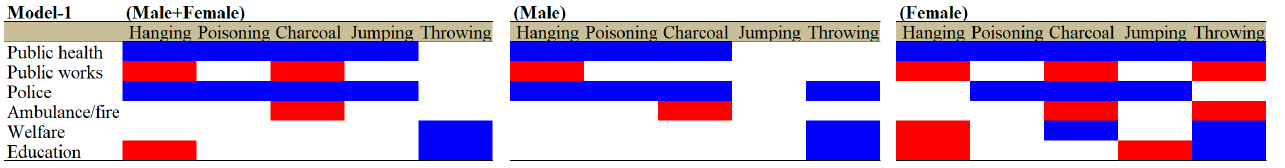
Figure 1. Impacts of total amount of the financial expenditure of six divisions (public health, public works, police, ambulance/fire, welfare and education) prefectures/municipalities on suicide mortalities by five major suicide means (hanging, poisoning, charcoal burning, jumping and throwing suicide) of both gender (males plus females), males and females between 2009 and 2018 using fixed-effect model analyses of hierarchal linear regression with robust standard error. Blue and red columns, significant factors for decreasing and increasing suicide mortalities, respectively.